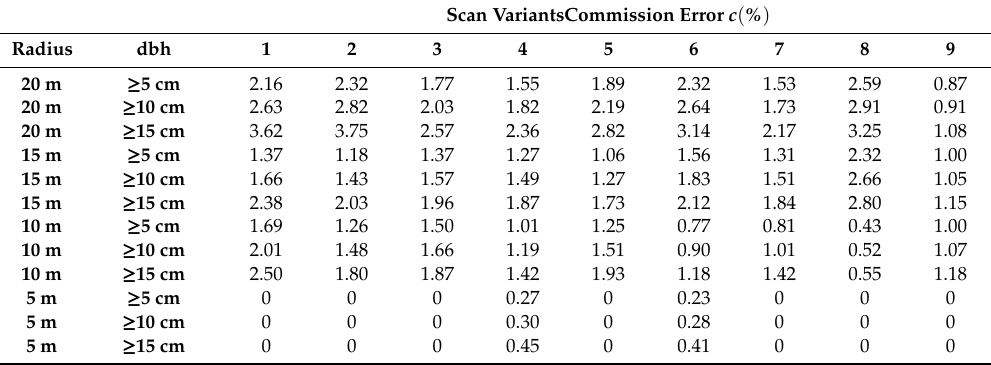
Table A4. Commission errors for di ff erent scan variants, lower dbh thresholds, and plot radii.